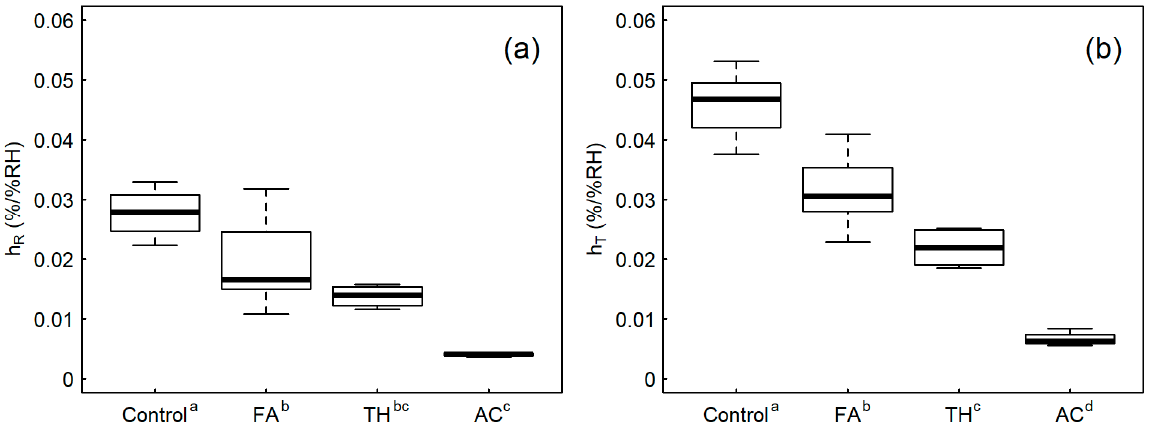
Figure 6. Radial ( a ) and tangential ( b ) dimension change for each 1% change in relative humidity (h R and h T , respectively). Superscripted letters on the x -axis indicate significant differences according to Tukey’s HSD test (95% confidence